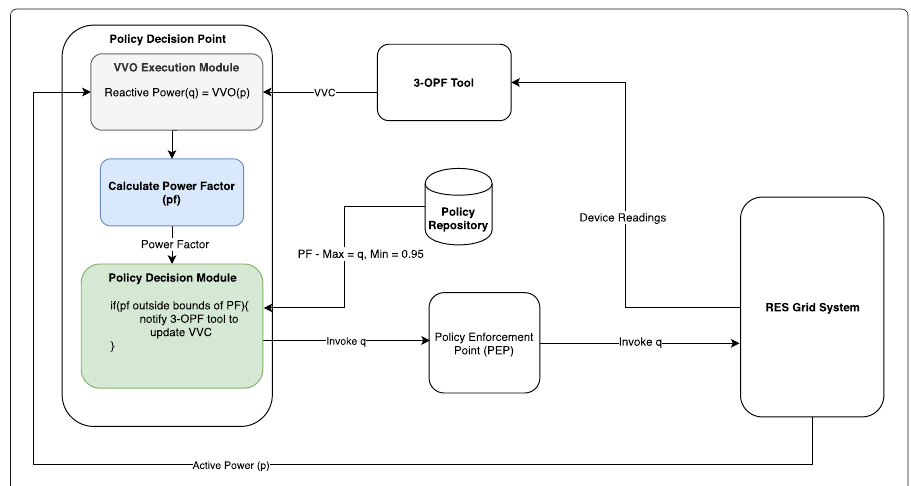
Fig. 7 Volt VAr Curve Update PBNM